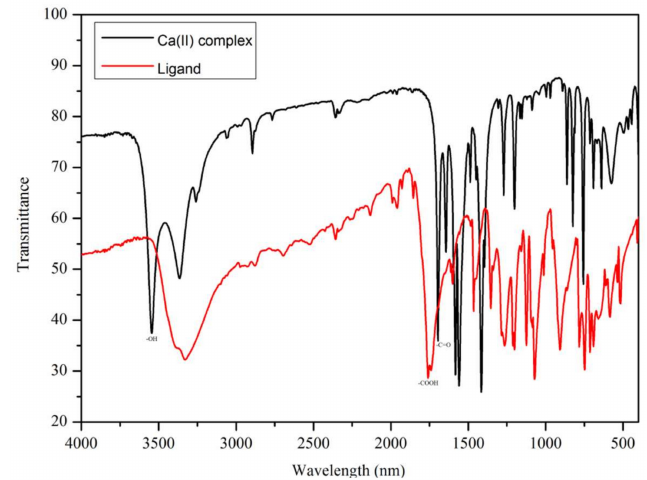
Figure 1. The IR spectra of 2-carboxybenzaldehyde and [Ca(L) 2 (H 2 O) 2 ] n .